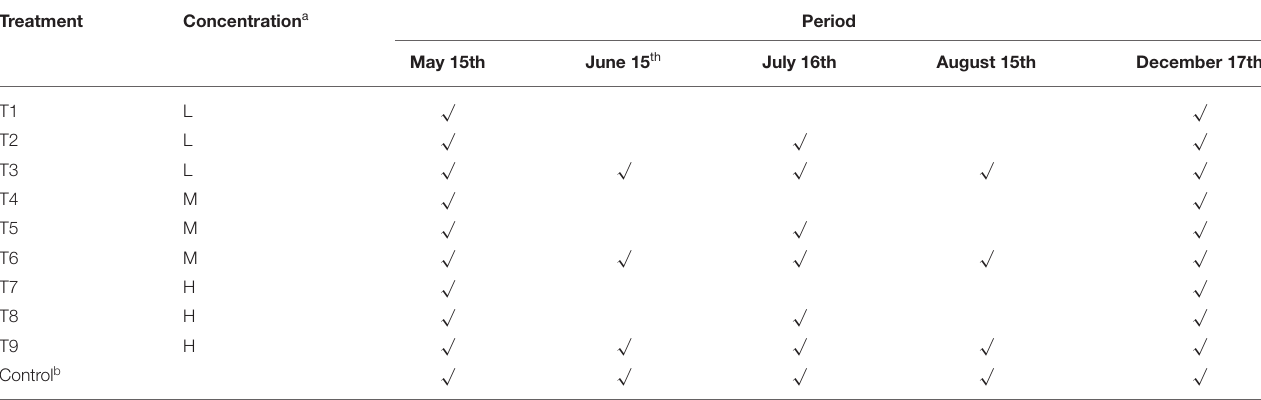
TABLE 1 | The design of the spray treatment of MRPs- Ca/Fe/Zn.